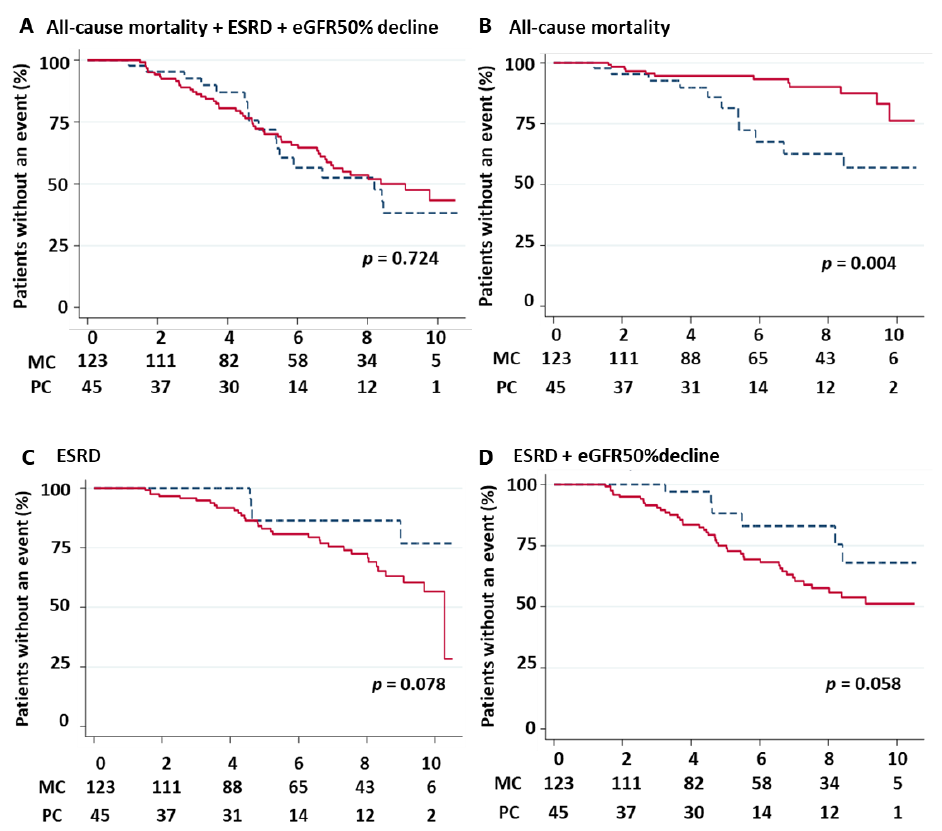
Figure 3. Kaplan–Meier analyses for primary and secondary outcomes based on baseline medical cooperation. The red solid line represents the event-free time of the medical cooperation group. The blue dash line represents the event-free time of the primary care group. The survival curves were compared in medical cooperation for ( A ) All-cause mortality + ESRD + eGFR50% decline, ( B ) All-cause mortality, ( C ) ESRD, ( D ) CKD progression (ESRD + eGFR 50% decline). Abbreviation: MC, medical cooperation. PC, primary care; ESRD, end-stage renal disease. Table 2. Competing-risk model of variables associated with the cumulative incidence of all-cause mortality or ESRD/50% eGFR